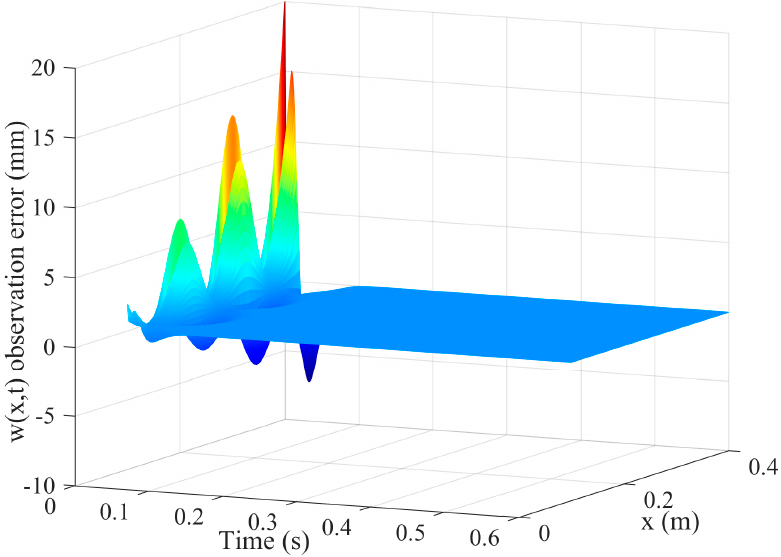
Figure 5. Tracking error of the vibration displacement of the TFM.